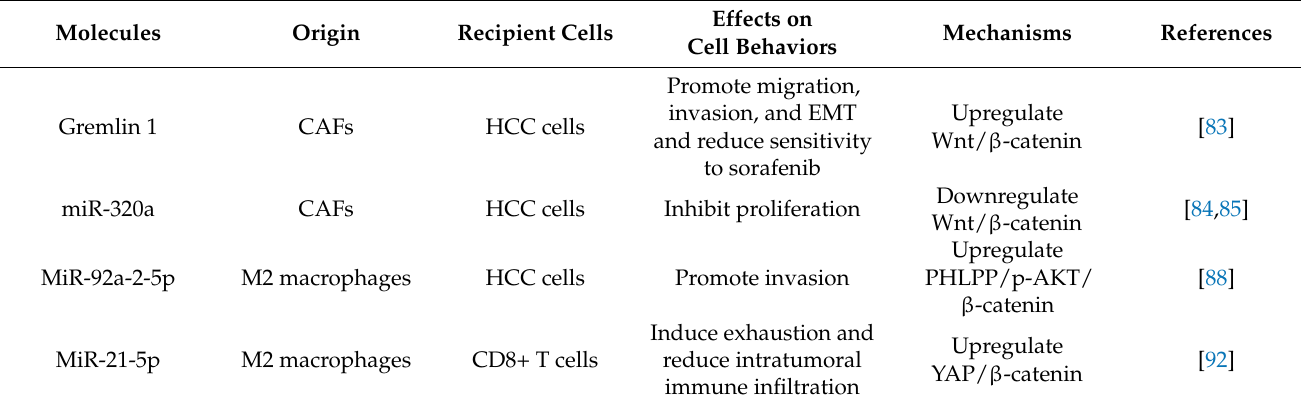
Table 2. EVs derived from CAFs and M2